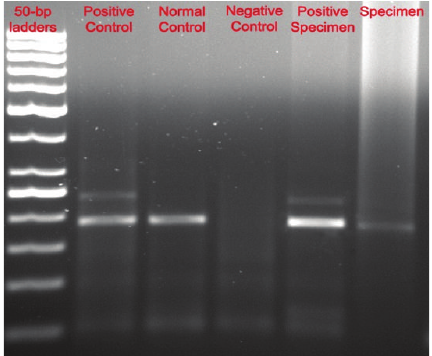
Figure 4: The 191bp of PCR product in this case (in specimen lane) substantially suggested that there was no ITD-mutant exon-1, as well as in the normal control. Notably, the PCR products of the positive control and the positive specimen from the other case consisted of 2 distinct bands at 191bp and 250bp